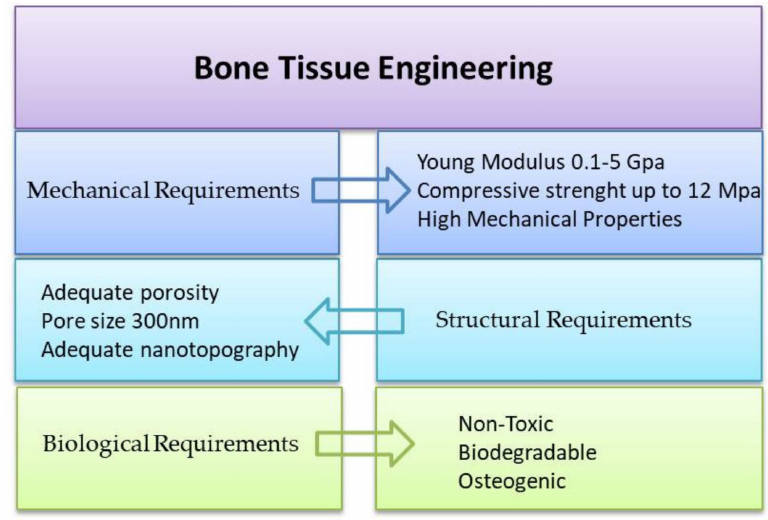
Figure 2. Scaffold requirements for the bone tissue engineering